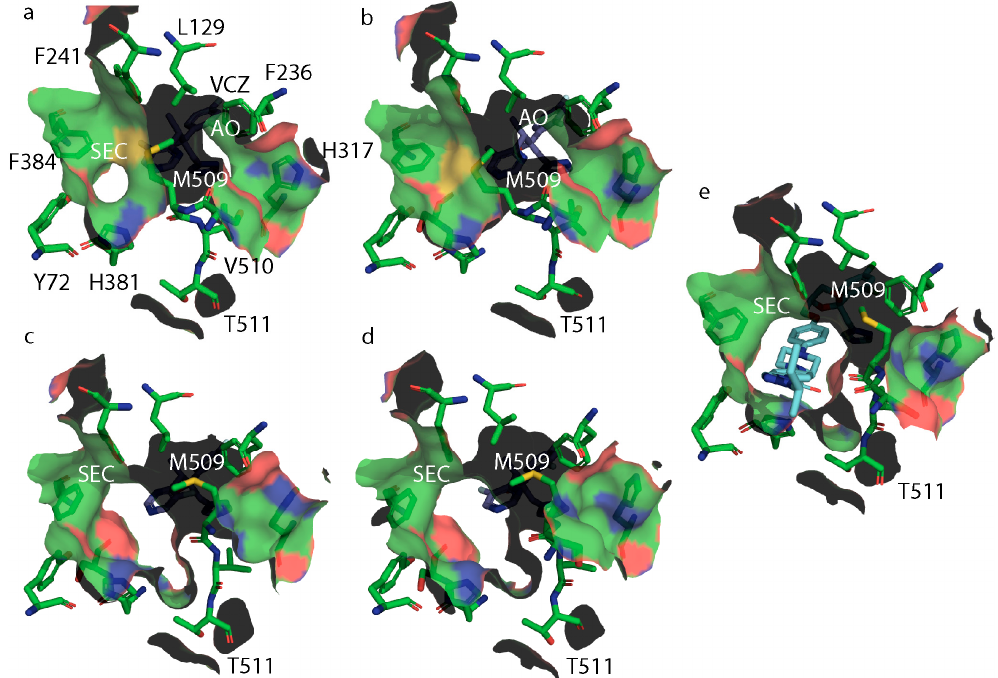
Figure 7. Surface structures at the neck of the substrate entry channel in ScLDM6×His and its mutants in complex with VCZ or ITC. ( a ) ScLDM6×His (WT) + VCZ (PDB ID: 5HS1); ( b ) ScLDM6×His Y140H + VCZ (PDB ID: 7RY8); ( c ) ScLDM6×His I371T + VCZ (PDB ID: 7RY9); ( d ) ScLDM6×His Y140H Y471T + VCZ (PDB ID: 7RYB); and ( e ) ScLDM6×His I371T + ITC (PDB ID: 7RYA). For protein: O atoms in red, N atoms in blue, S atoms in mustard. For VCZ and ITC: carbon in purple, nitrogen in blue, and fluorine or chlorine in white. The surface net reflects the color of adjacent protein residues. SEC, substrate entry channel. AO, accessory